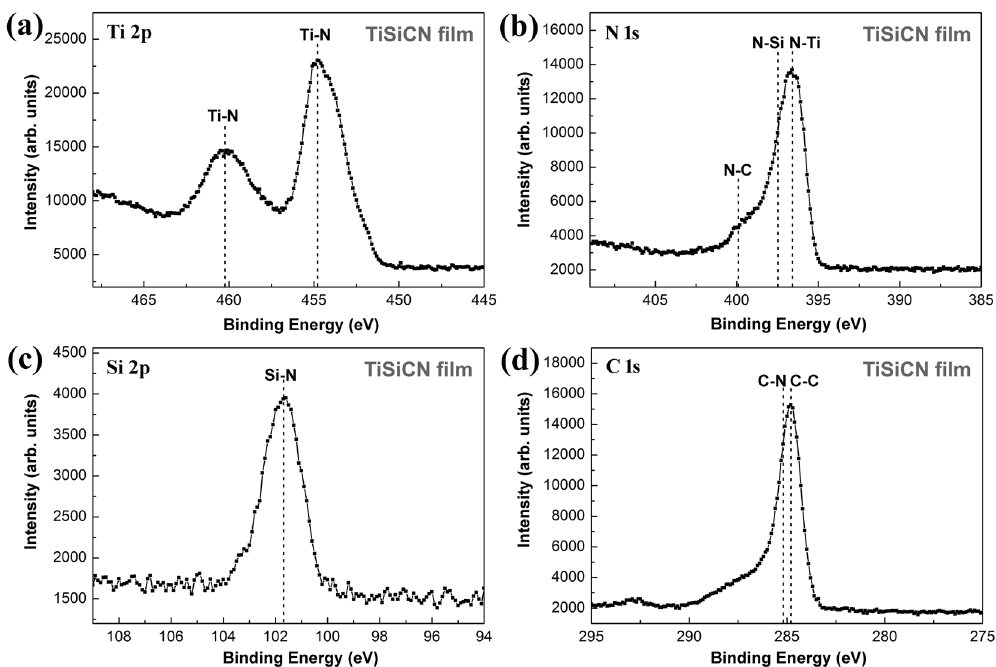
Figure 4. XPS spectra of the TiSiCN nanocomposite film with the C/Si content ratio of 2:2. ( a ) Ti 2p, ( b ) N 1 s, ( c ) Si 2p, and ( d ) C 1 s. The TiN, Si 3 N 4 , C, and CN x can be identified. No information of TiC can be detected in the